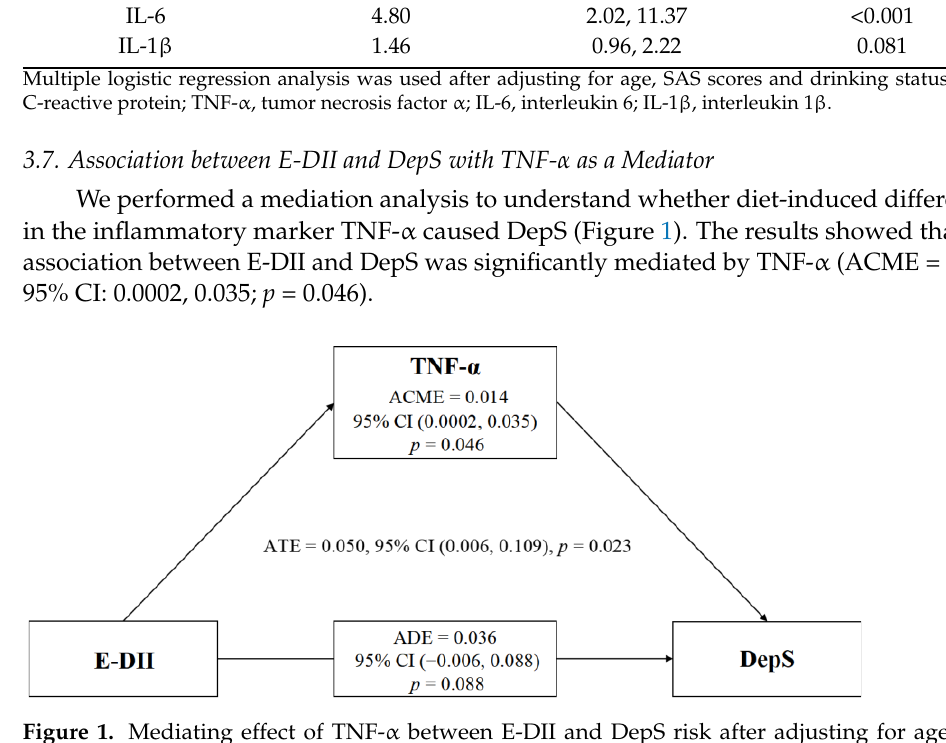
Figure 1. Mediating effect of TNF- α between E-DII and DepS risk after adjusting for age, SAS scores, and drinking status. The 95% confidence interval (CI) in brackets was computed from 5000 nonparametric bootstrap replicates. E-DII, energy-adjusted Dietary Inflammatory Index; TNF- α , tumor necrosis factor α ; DepS, depressive symptoms; ACME, average causal mediation effect; ADE, average direct effect; ATE, average total